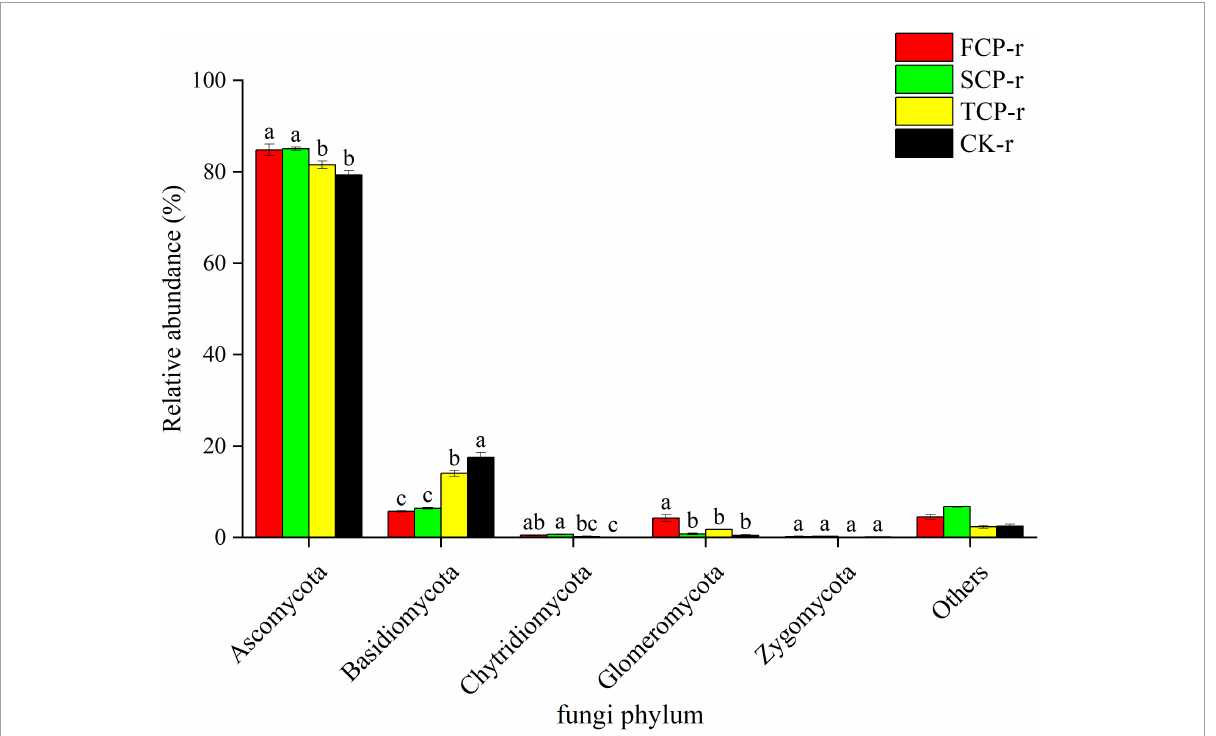
FIGURE3 Relative abundance of predominant fungal community in successive generations within rhizosphere soil at the phyla level. Other stands for undefined categories. Value show means ± standard error ( n = 3). Different lowercase letters show significant differences. CK, Nanmu seedings; FCP, first-generation seedings; SCP, second-generation seedings; TCP, third-generation seedings. r, rhizosphere